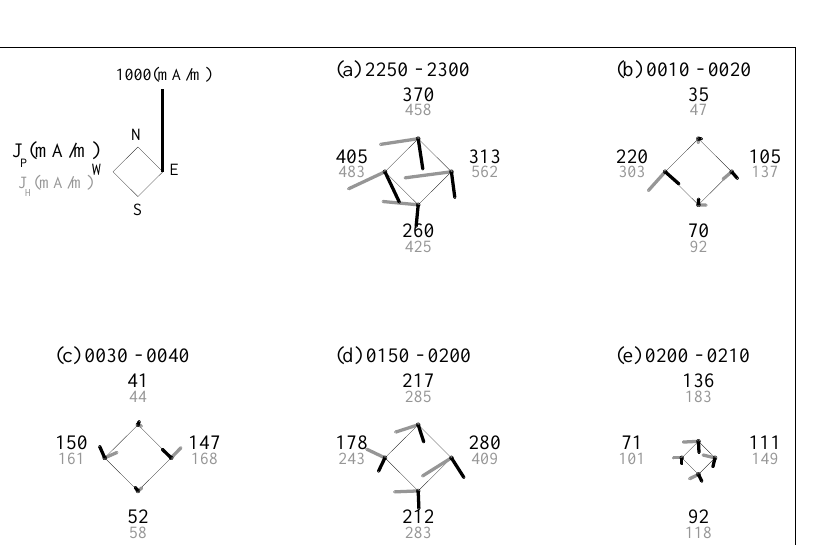
Fig. 5. Spatial variations of the con- ductance and the electric field observed with the EISCAT radar. Each position of the quadrilateral corresponds to the four beam positions, respectively; bot- tom (south, beam 1 or 5), top (north, beam 2 or 6), left (west, beam 3 or 7), and right (east, beam 4 or 8). Each thick line indicates the strength and direction of the electric field. The Pedersen (up- per) and Hall (lower) conductances are denoted in the unit of S.